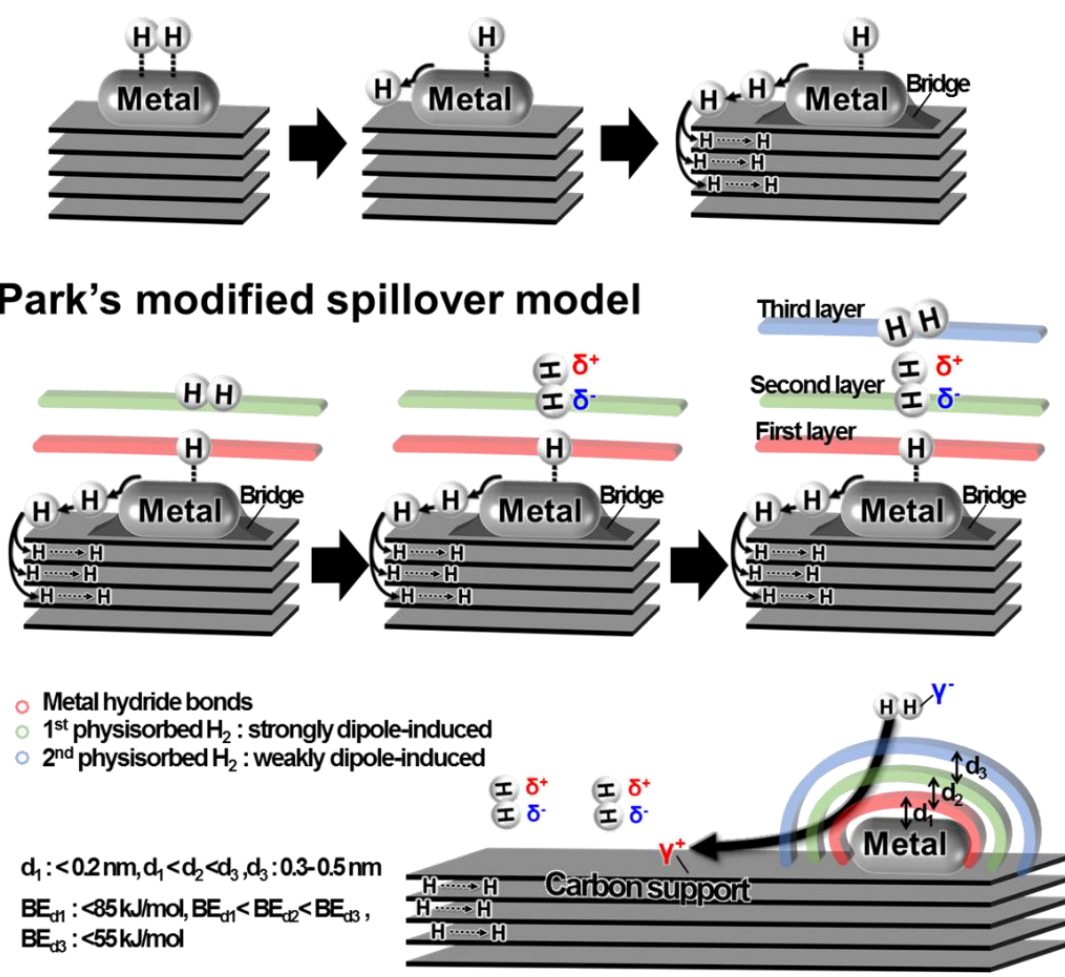
Figure 12. Comparison of two representatives: Yang’s spillover model and Park’s modified spillover model in H 2 storage (d n : distance between the metal and the number of the hydrogen layers; BE dn : binding energy between two d n s).